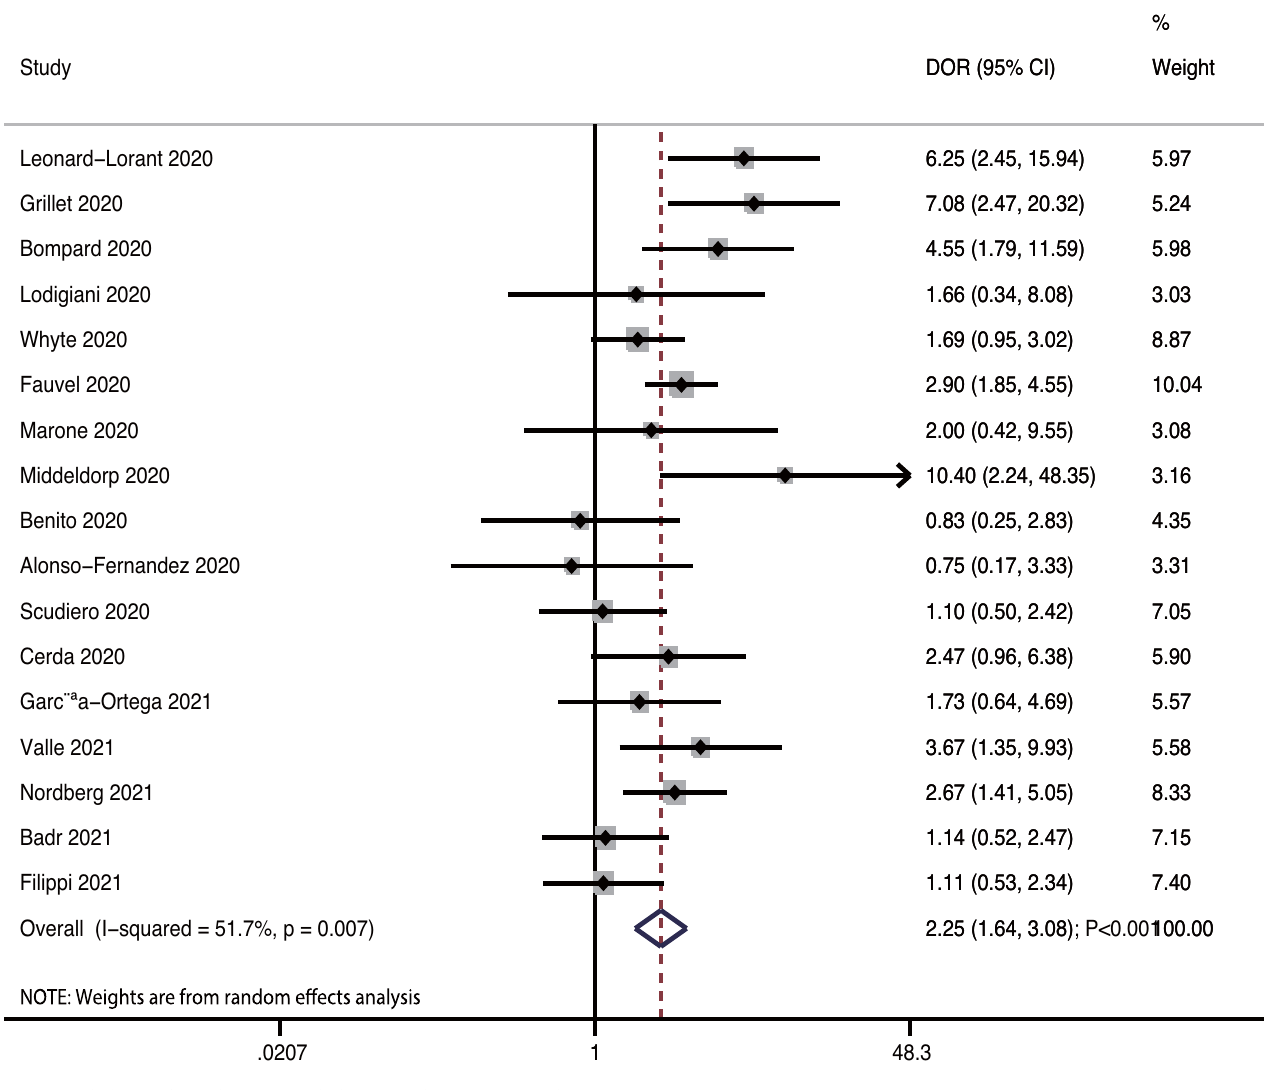
Fig 5. Pooled DOR for pulmonary embolism on subsequent ICU